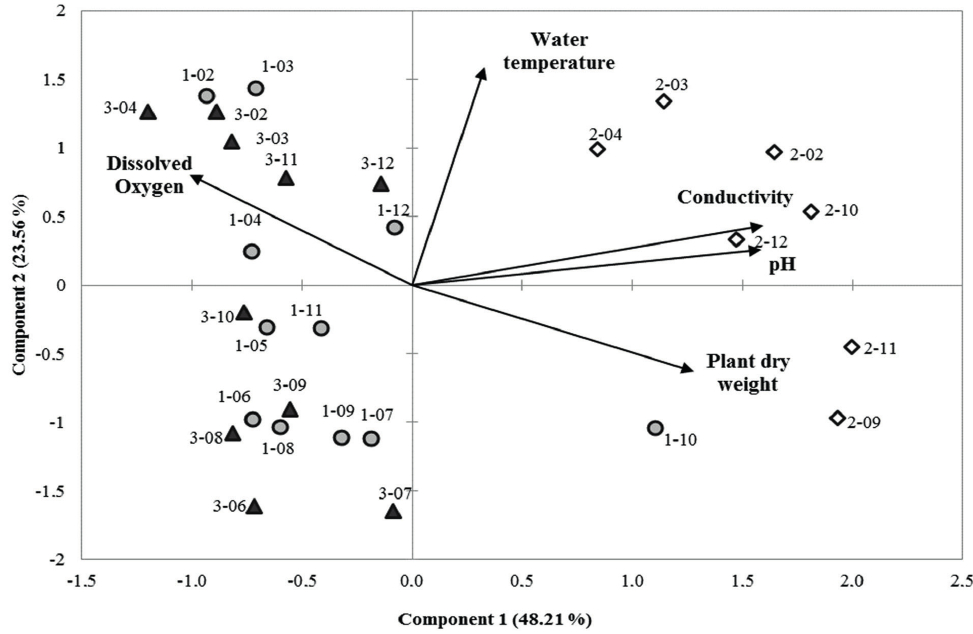
Figure 2 - PCA biplot. Variables: Water temperature (°C), pH, Dissolved Oxygen (mg/l), Conductivity (μS/ cm) and Plant dry weight (g/m 2 ). Two numbers represent each sample, the first one corresponds to the study site (1, 2 or 3), and the second one corresponds to the sampling